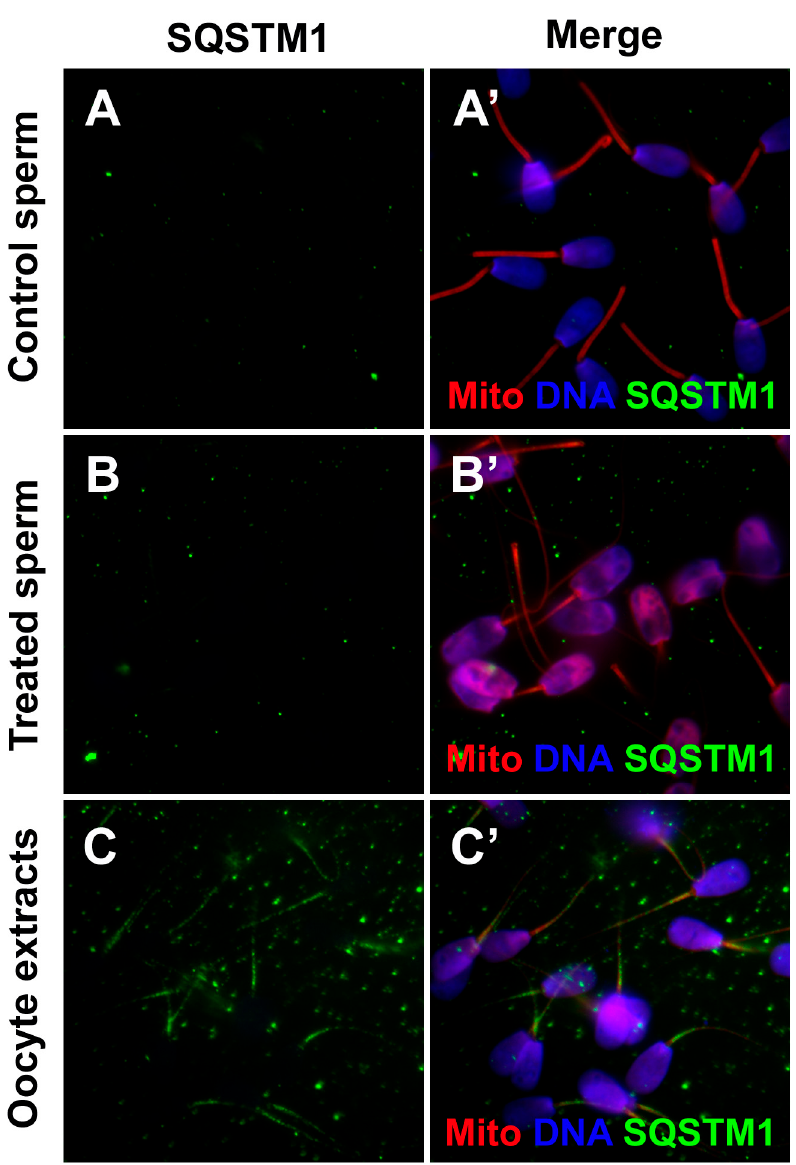
Figure 7. Binding of ooplasmic SQSTM1 to bull sperm mitochondria co-incubated with porcine oocyte extracts. Control bull spermatozoa pre-labeled with MitoTracker ( A , A’ ) and bull spermatozoa primed with 0.05% lysolecithin and 10 mM DTT ( B , B’ ) were immunolabeled with anti-SQSTM1 antibody. There was no SQSTM1 labeling in bull sperm mitochondria prior to co-incubation. ( C , C’ ), Spermatozoa primed with 0.05% lysolecithin and 10 mM DTT and co-incubated with porcine oocyte extracts for 4 h, showed immunolabeling with anti-SQSTM1 antibody. Original magnification: 1000× .